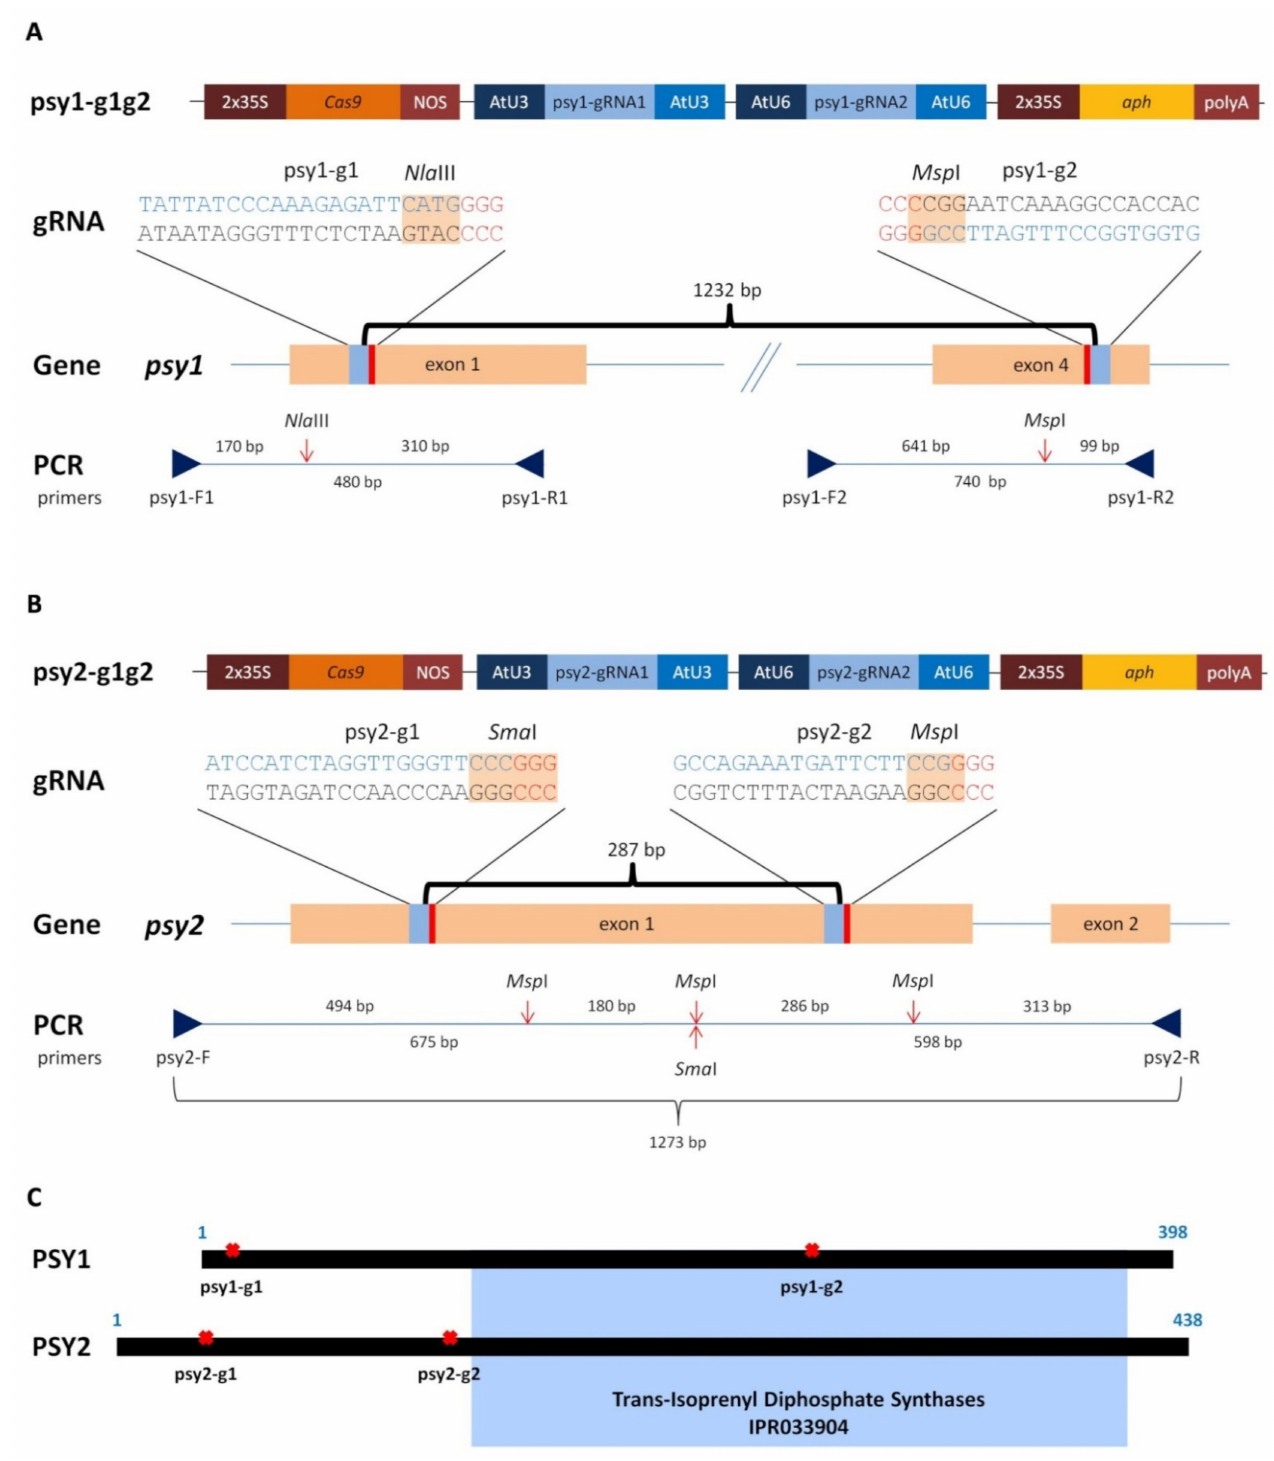
Figure 1. A scheme of Cas9 vectors (psy1-g1g2 and psy2-g1g2), each with two gRNAs (g1 and g2) targeting psy carrot genes and the PCR amplified fragments with primer names, restriction sites, and their lengths for ( A ) psy1 and ( B ) psy2 . ( C ) A linear scheme of PSY protein with the conserved domain marked in blue. The restriction sites are marked by red arrows and the gRNA:Cas9 target sites are marked by red